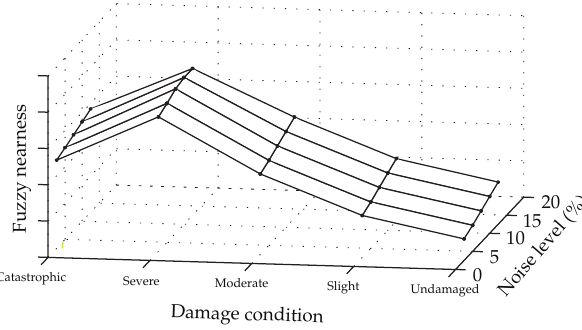
Figure 9: Antinoise analysis of fuzzy nearness-based method.